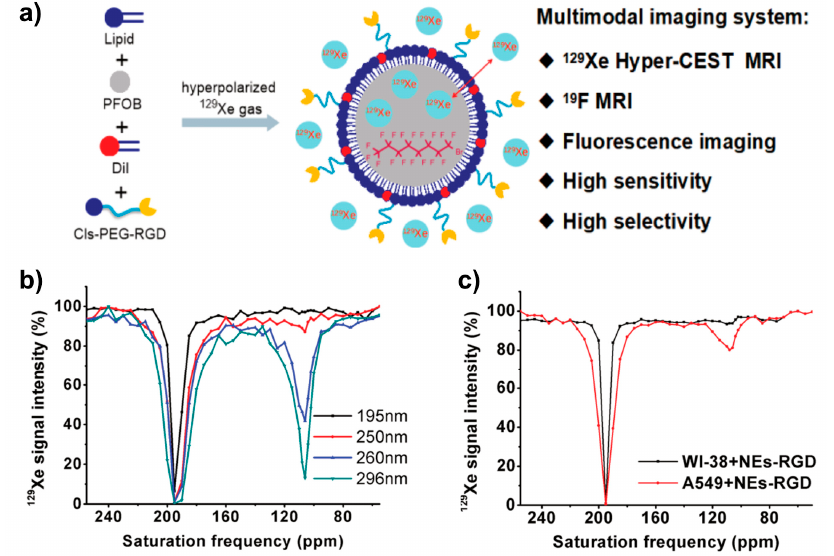
Figure 12. Application of PFOB nanodroplets as HyperCEST agents. ( a ) Sketch of nanodroplet structure. ( b ) z-spectra for different nanodroplet sizes. The CEST response increases with the droplet